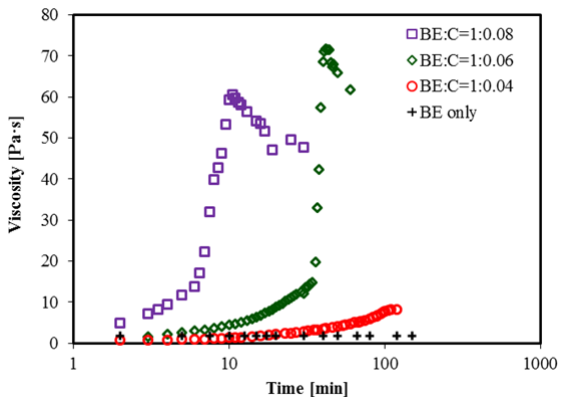
Figure 1. An example of gelation time of various cement ‐ bitumen emulsion blends (adapted from [41], the legend shows bitumen emulsion to cement ratio, BE refers to bitumen emulsion and C refers to cement, BE only refers to reference sample without